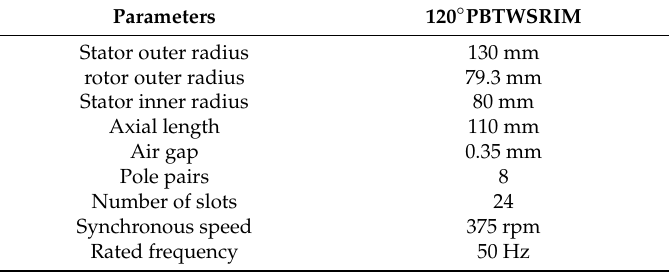
Table 1. 120 ◦ PBTWSRIM